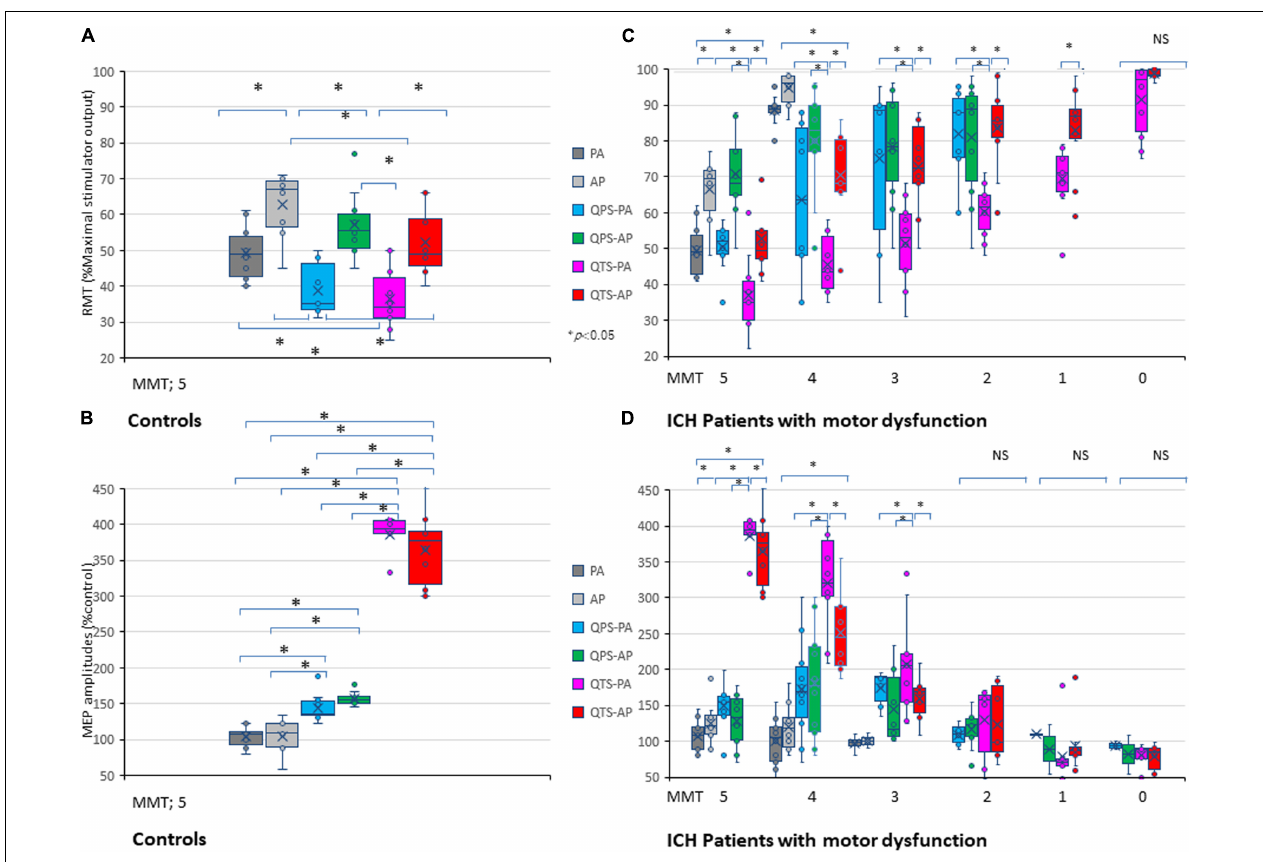
FIGURE 4 | Five hundred-Hertz quadripulse theta burst transcranial magnetic stimulation (QTS), 500 Hz-single burst, and single pulse: comparison of characteristic resting motor threshold (RMT) and amplitude profiles, and the correlation between manual muscle testing (MMT) grades. Quantitative differences in motor evoked potential (MEP) baseline parameters between the six stimulus conditions were statistically significant in RMT (A) and amplitude (B) in healthy controls ( p < 0.05). RMTs were significantly higher in the AP direction in all QTS, QPS, and SP configurations ( p < 0.05). A multiple comparison test revealed significant differences in RMT and MEP amplitudes, and that the QTS induces higher amplitudes with lower stimulus intensities in healthy controls ( p < 0.05). Significant differences were found in RMT (MMT grades 5–1) and amplitude (MMT grades 5–3) in patients with ICH [Panels (C,D) ; p < 0.001]. There were significant correlations between MMT neurological grades and RMTs, and QTS-PA/AP-MEP amplitudes ( p < 0.001, respectively), but not those of QPS-AP/PA or single-pulse-PA/AP. Colors in the graph represent each condition before and after TMS [red: 500-Hz QTS-AP, pink: 500-Hz QTS-PA; green: 500-Hz QPS-AP; light blue: 500-Hz QPS-PA; dark gray: single-pulse PA; light gray: single-pulse-AP in healthy controls (A,B) and MMT-parameter correlations in patients with ICH (C,D) , respectively]. * p <